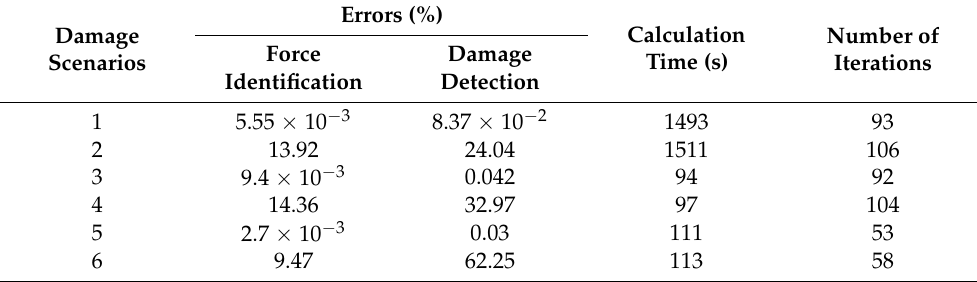
Figure 5. Hysteresis loop of the base isolation.